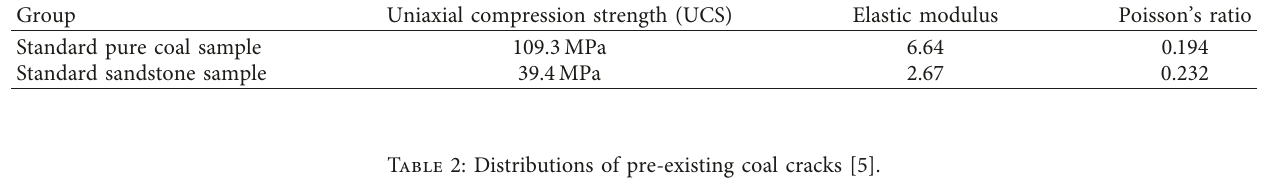
Table 1: Mechanical properties of standard pure coal and rock samples [21].